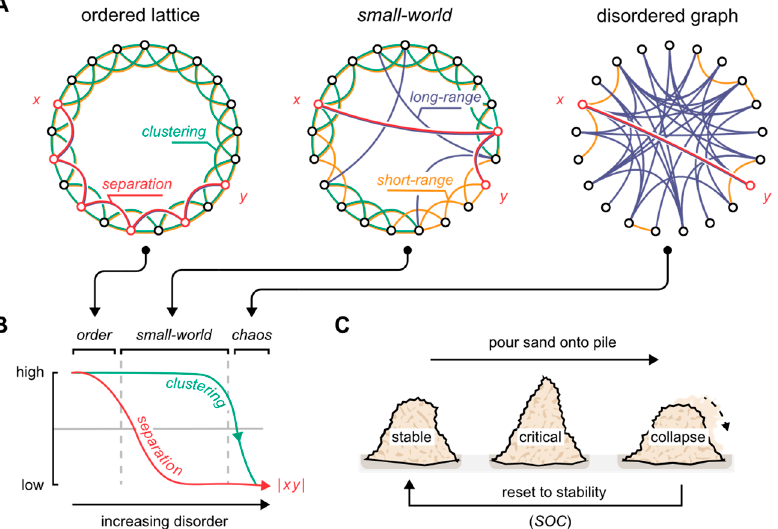
Figure 1. The small-world topology. ( A ) By randomly rewiring an ordered lattice, it transitions into a disordered graph. Through this transition, the small-world arrangement defines a critical state. x and y demarcate two arbitrary nodes on the graph, connected by a red line through the shortest path length between the nodes. ( B ) With increasing disorder, or randomness, the separation between the network’s nodes rapidly decreases (red), while clustering remains practically unchanged (green). The small-world topology corresponds to the mid area marked by high clustering and low separation properties. The x -axis is logarithmic. ( C ) Criticality defines the state of a system undergoing a phase transition, a classic example being a sandpile on the verge of collapse [35]. As sand is poured onto